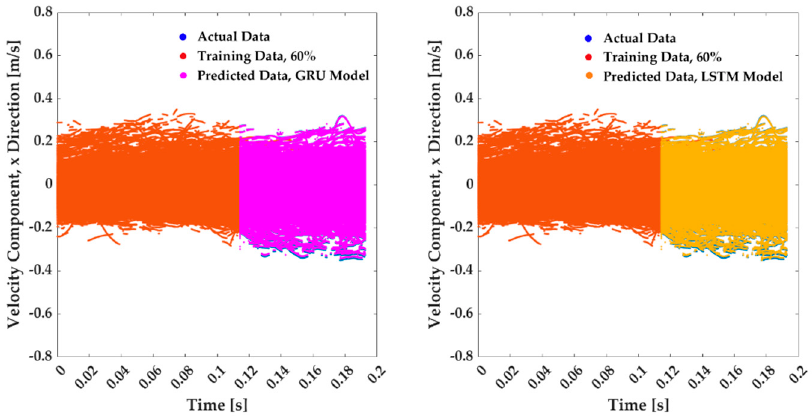
Figure 9. Prediction of velocity component in the x direction for a strained turbulent flow with mean strain rate 8 s − 1 , GRU model on the left ‐ hand side, and LSTM model on the right ‐ hand side. Training data are 80% and test data 20%.